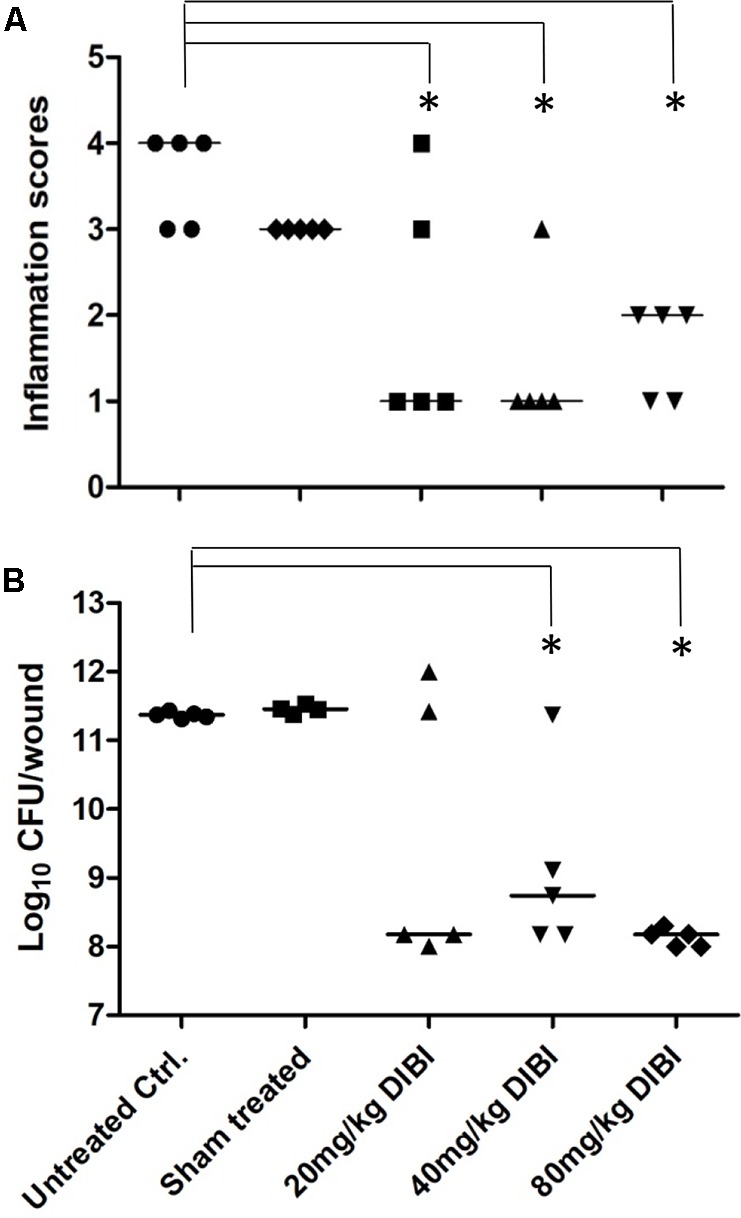
DIBI suppresses S. aureus wound infection. Mouse dorsal stripped skin wound patches were infected with S. aureus ATCC43300. DIBI was applied topically to the wounds at various dosages. At 4d PI, wounds were scored for inflammation (A) and the mice were sacrificed for total wound bacterial CFU burden determination by plate counting (B). Anti-infective responses were evaluated by comparison to the untreated infected controls. Inflammation scores and the log10 of bacterial counts (CFU/wound) are presented with their median value. (∗) significant with p < 0.05.